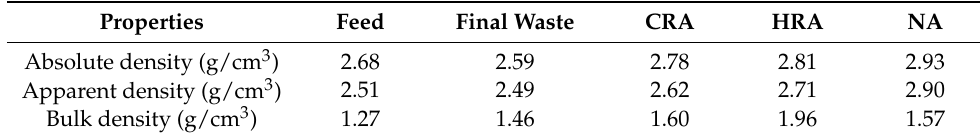
Table 8. Densities of obtained products and natural aggregate. Properties